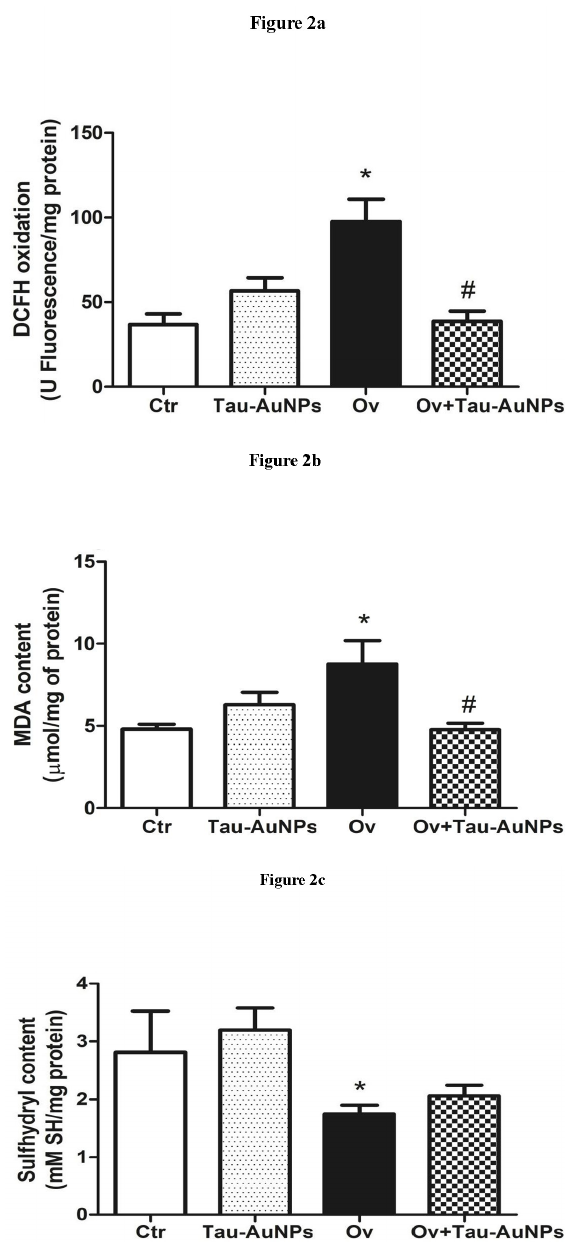
Figure 2. DCFH oxidation (a) and oxidative damage in the lipids (b) and thiol groups (c) of the quadriceps muscles of mice submitted to muscle overuse and tau-AuNPs administration. The results are expressed as the mean and SEM and were analyzed by one-way ANOVA followed by the post-hoc Bonferroni test. *p≤0.05 compared to the control; #p≤0.05 compared to the overuse group. All statistical analyses were performed using Graph Pad Prism 7 software. Groups: control (Ctrl), tau-AuNPs, overuse (Ov), overuse plus tau-AuNPs